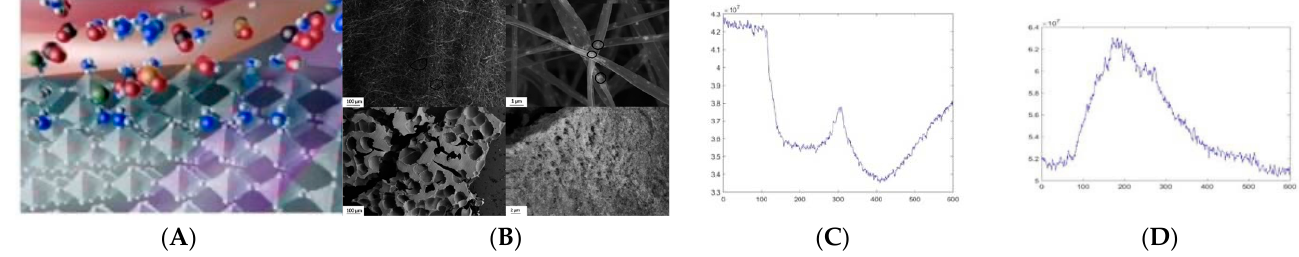
Figure 5. ( A ) Illustration of selective ammonia (blue molecules) chemosensing by metal oxide (MoO 3 ) nanoprobes; ( B ) metal-oxide (WO 3 ) foam structures [28]; and ( C ) and ( D ) output signals from sensing volatile biomarkers for pathogen vs. normal response, respectively [6].